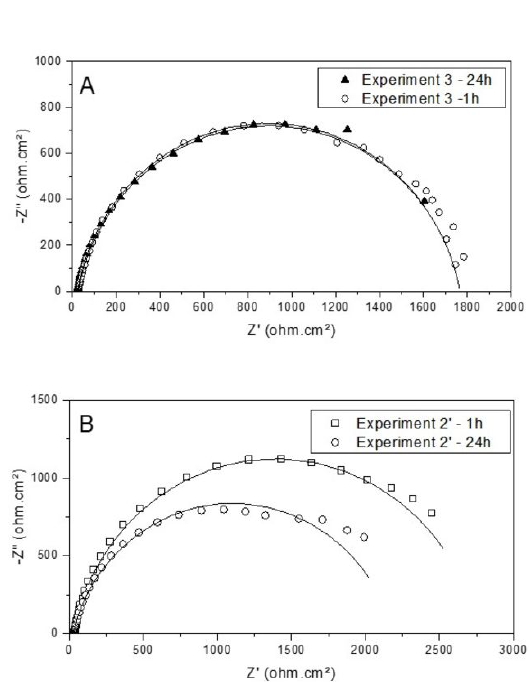
Figure 9. Nyquist diagram for the Cu-Sn coating/substrate obtained using the conditions of (A) Experiment 3 and (B) Experiment 2’, after 1 h and 24 h of immersion in NaCl 0.5 mol L -1